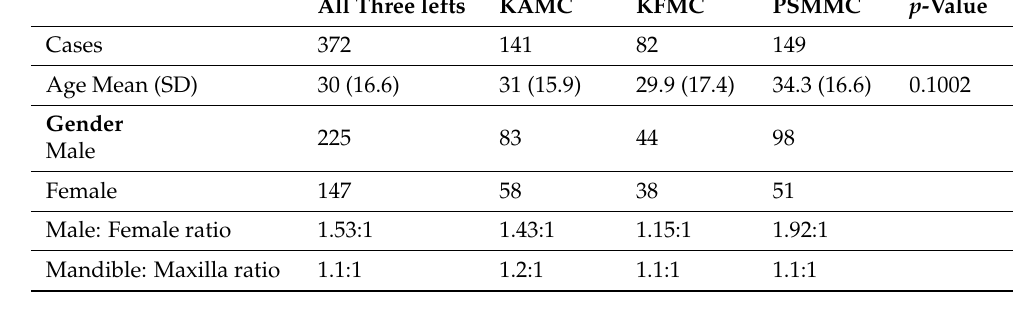
Figure 2. ( A ) OC distribution at each center. ( B ) Distribution of OCs at each center per year. PSMCC had the highest frequency in 2018. ( C ) Gender distribution of OCs. ( D ) Age distribution of OCs ( E ) Location distribution of OCs. Table 3. Summary of demographic in three different centers. Table 3. Summary of demographic in three different centers.